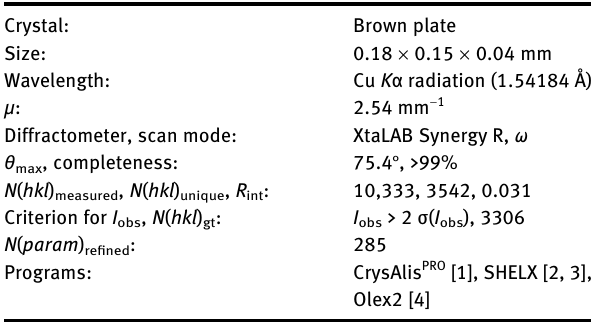
Table  : Data collection and